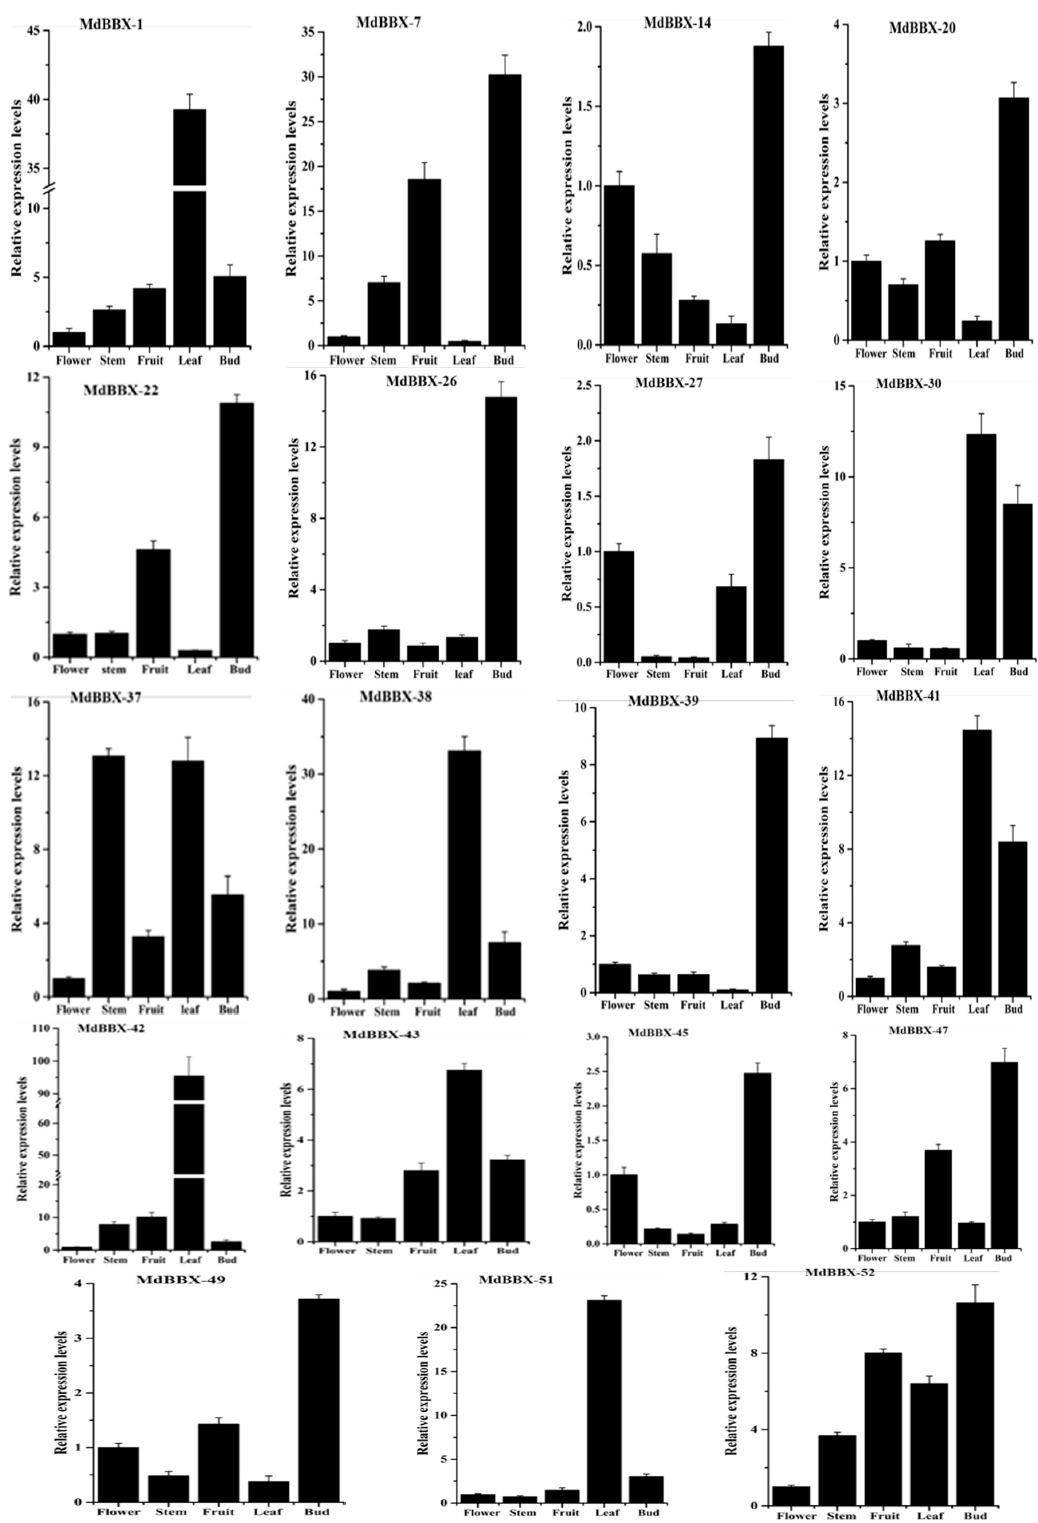
Figure 8. Expression profile of the MdBBX genes in tested tissues. The graphs indicate tissue-specific expression levels in the apple plant. The samples were collected in different developmental stages and were analyzed through qRT-PCR. The x -axis indicates the tissues. The y -axis shows the relative expression. The error bars indicate the standard deviations of the three independent qRT-PCR